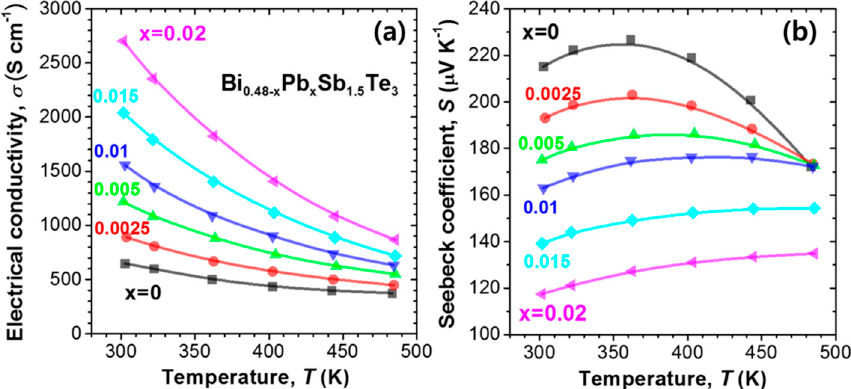
Figure 1. Temperature dependence of ( a ) electrical conductivity ( σ ) and ( b ) Seebeck coefficient ( S ) for Bi 0.48- x Pb x Sb 1.52 Te 3 ( x = 0, 0.0025, 0.005, 0.01, 0.015, and 0.02). The σ and S data were taken